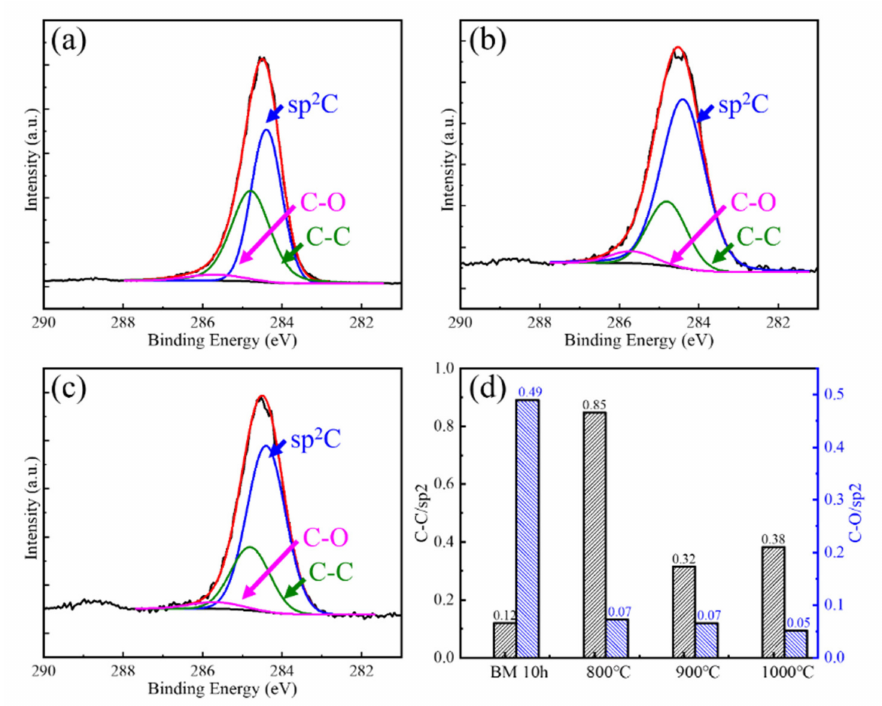
Figure 8. XPS characterization and fitting results of CVD repaired BM10h at different